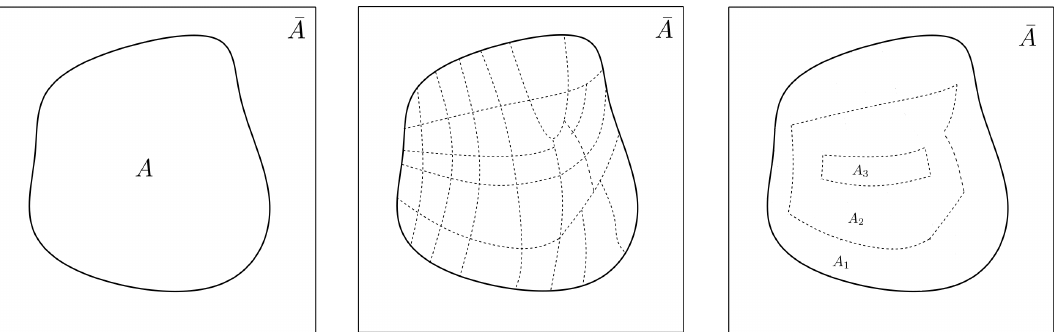
Figure 8: One procedure that resolves ordering ambiguity for the CMI proposal in higher dimensions. Elements in the partition of A are sorted into equivalence classes that are defined and ordered by their elements’ degree of separation from ¯ A